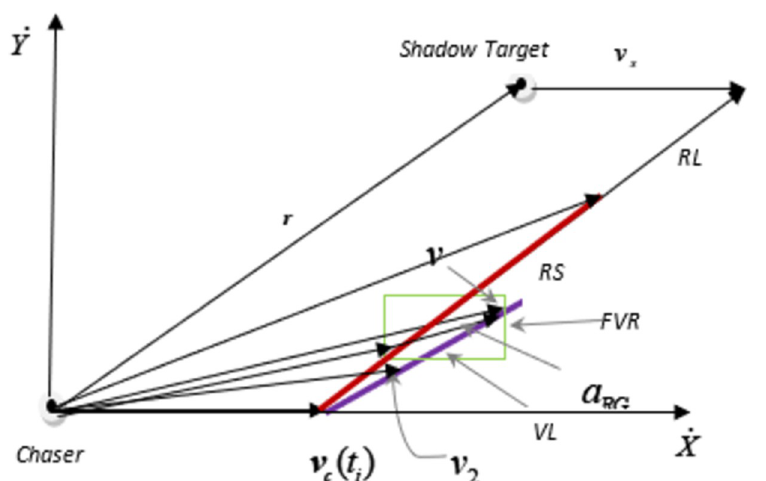
Fig 3. Generation of command for chasing